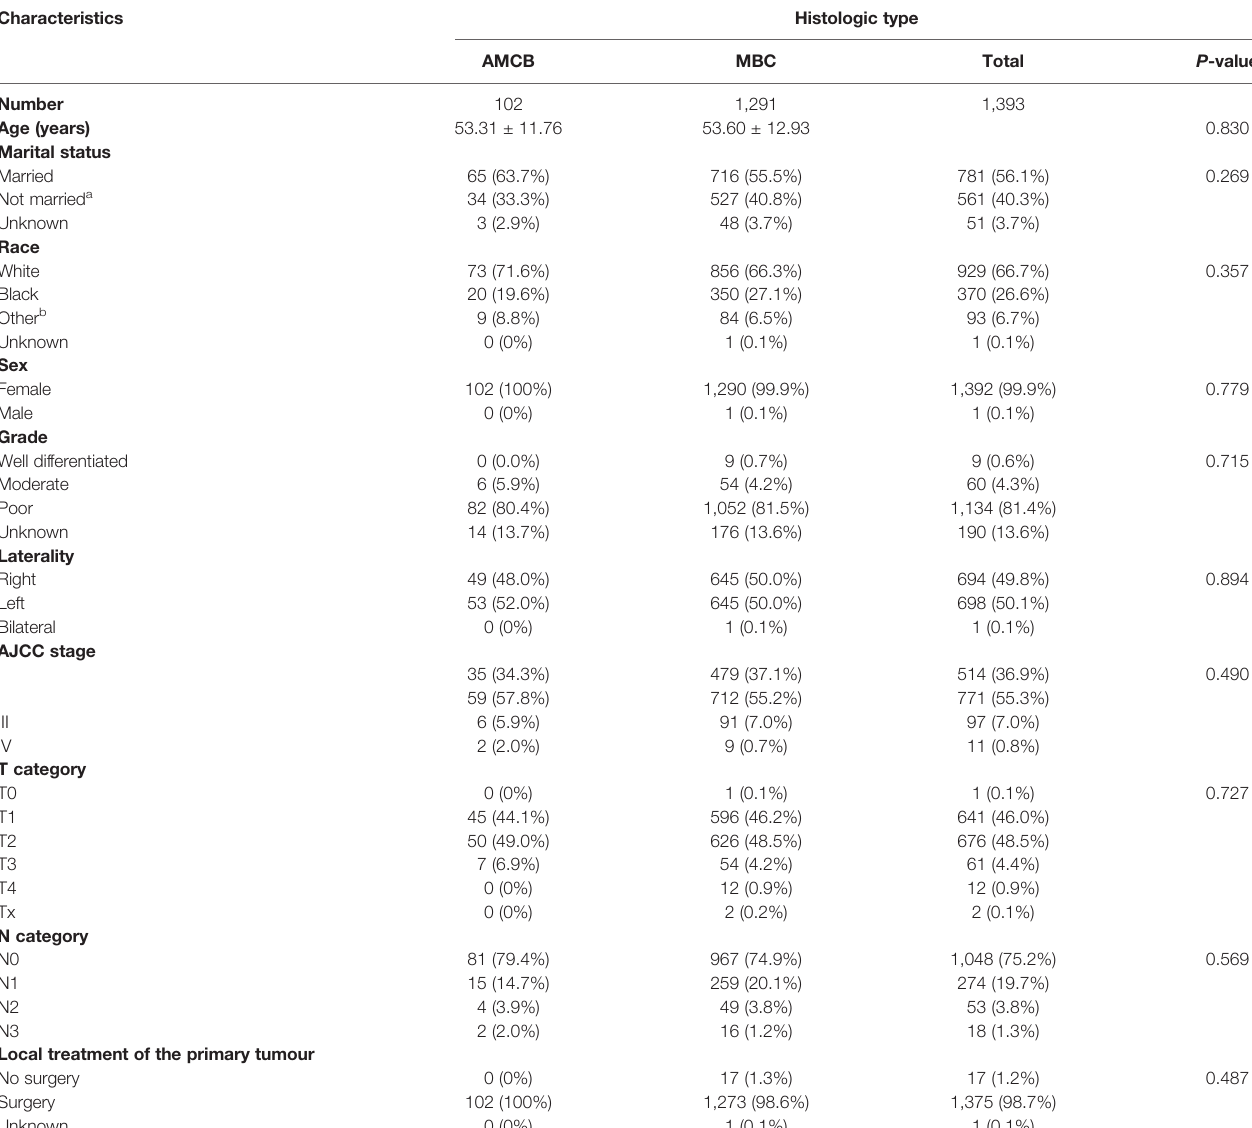
TABLE 5 | HR ( − ) patient characteristics with AMCB and